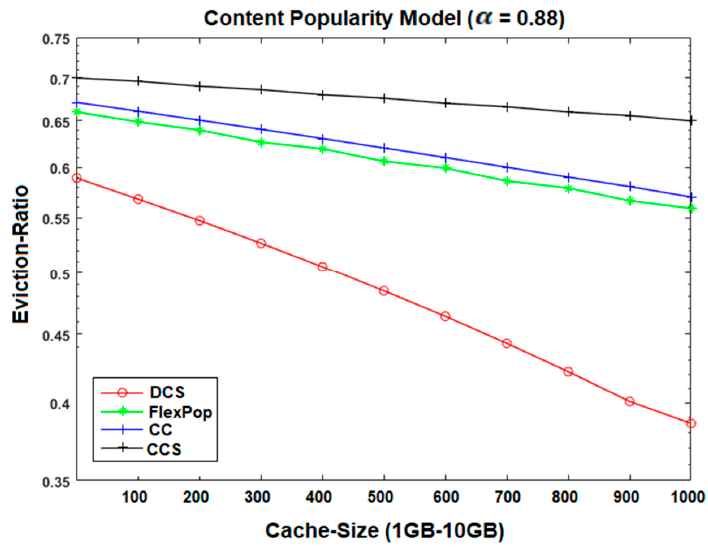
Figure 13. Content Eviction Ratio on Abilene Topology with UGC.